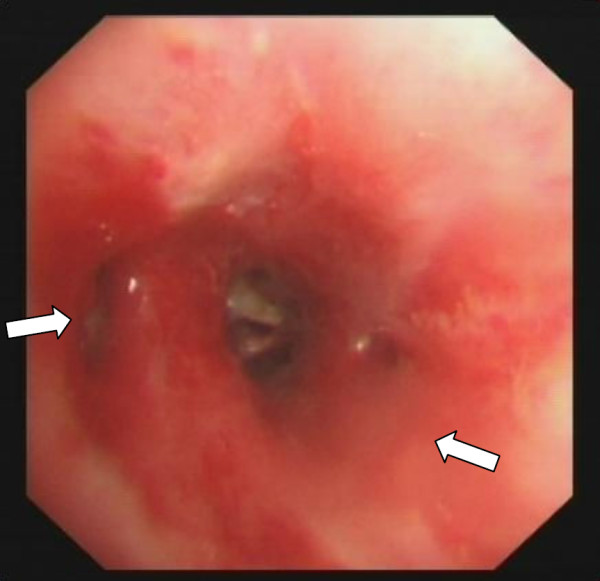
The middle and lower lobe of the bronchus were recovered after balloon dilation (arrows). (27 January 2012).